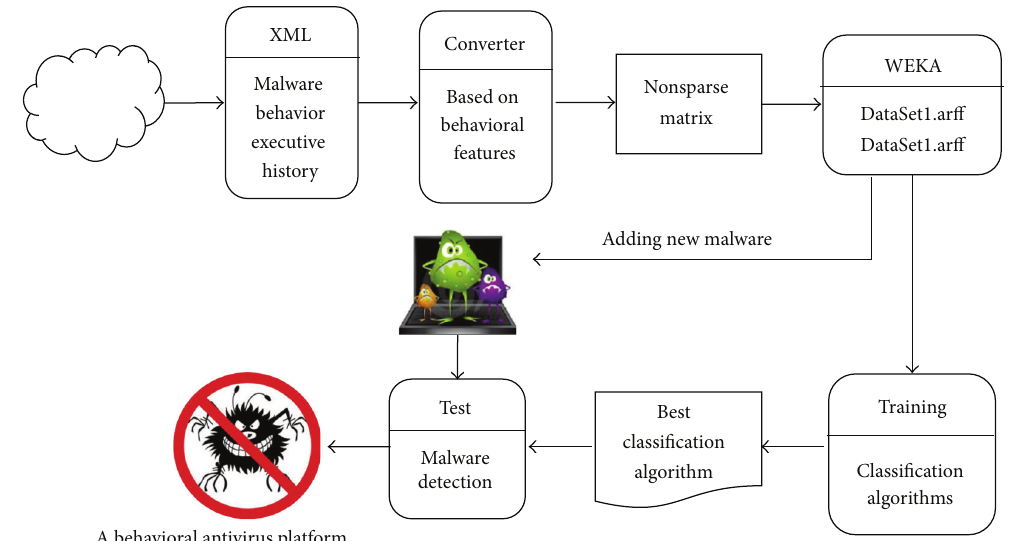
Figure 1: The behavioral analysis of malware detection mechanism.